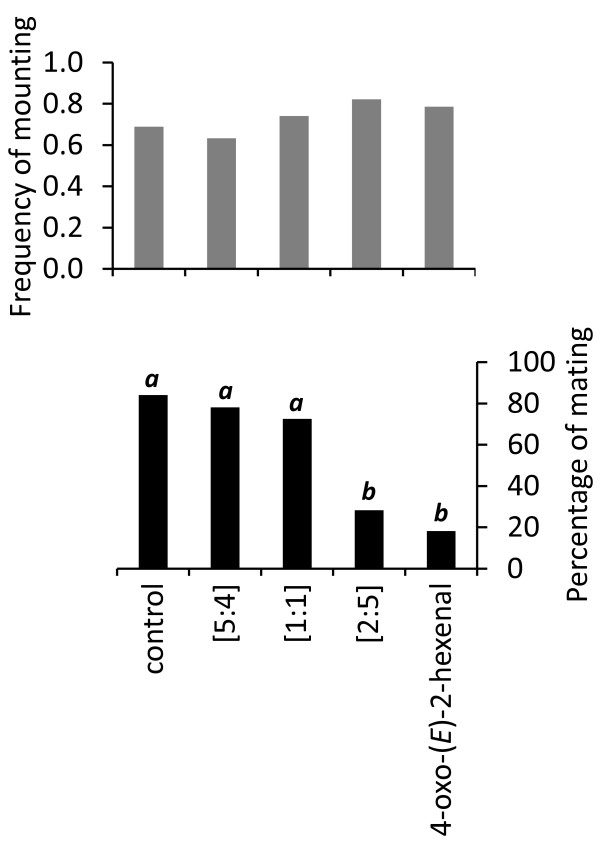
Behavioural experiments on alarm pheromone effect when puffed just after the Cimex lectularius male mounted a female. The male mating behaviour is regulated by nymph-emitted pheromone cues only. (a) Frequency of male mounting on females with covered methathoracic glands did not differ between the five experimental groups (n = 27-30; Kruskal-Wallis test: χ2 = 5.322, P = 0.256) before puffing. (b) Stimulation with a male [5:4] (n = 19) or a female [1:1] (n = 20) ratio of (E)-2-hexenal:(E)-2-octenal did not significantly alter the percentage of male mating with these females, compared to control. However, stimulation with either the nymph-specific ratio of these aldehydes [2:5] (n = 23)) or 4-oxo-(E)-2-hexenal (n = 22) caused a significant decrease in percentage of mating (Kruskal-Wallis test: χ2 = 35.602, P < 0.001; followed by Mann Whitney U-tests).